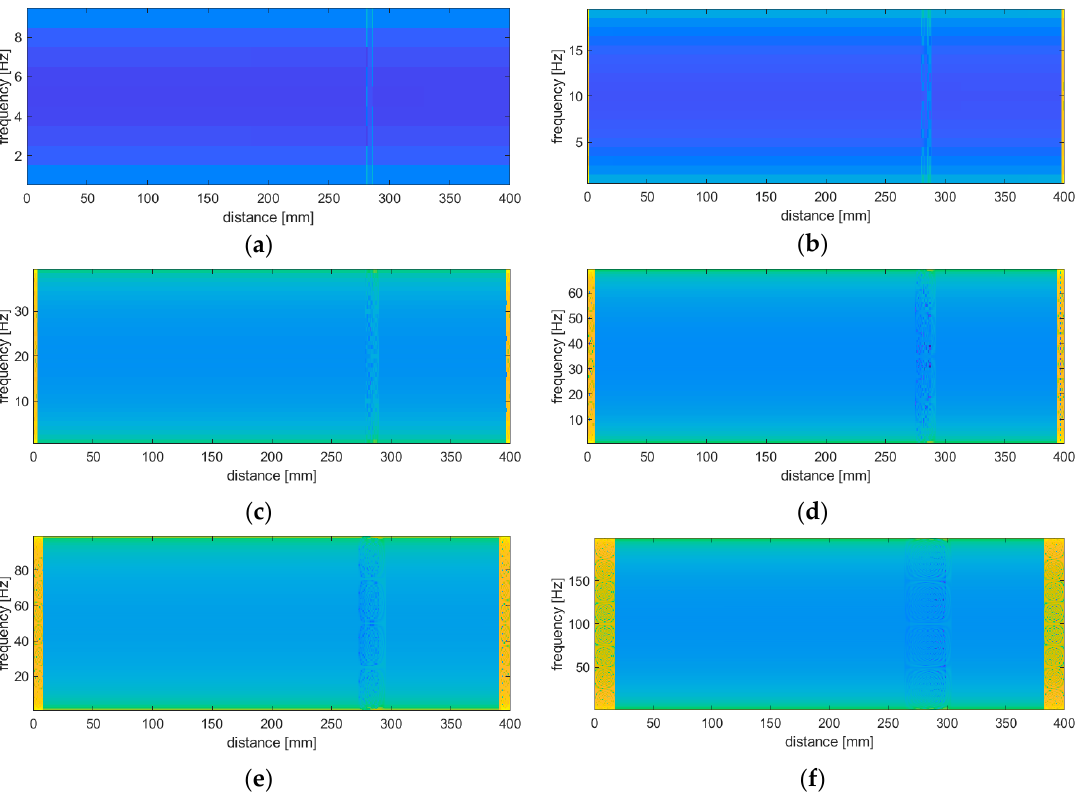
Figure 4. The influence of the frequency range on the damage detectability: the ranges of 0–10 Hz ( a ), 0–20 Hz ( b ), 0–40 Hz ( c ), 0–70 Hz ( d ), 0–100 Hz ( e ), and 0–200 Hz ( f ).